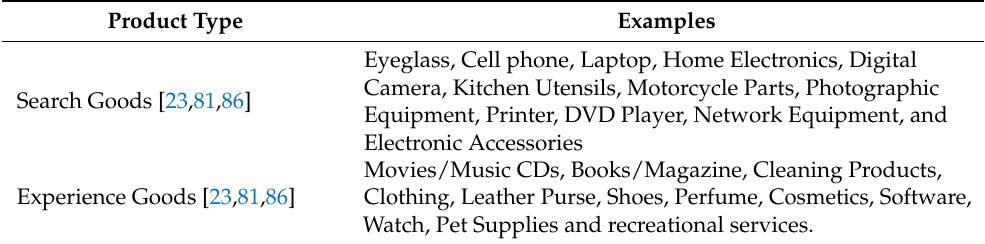
Table 2. Examples of search and experience